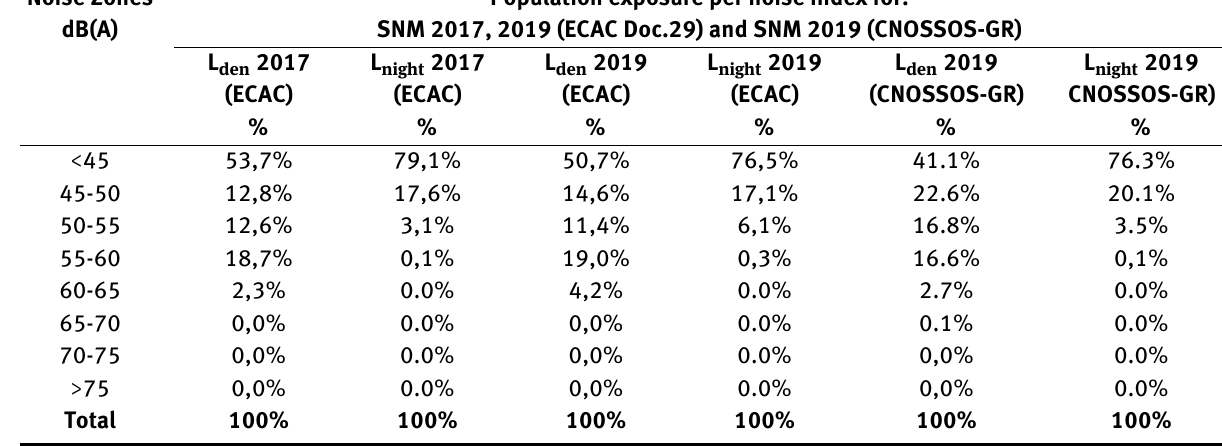
Table 4: Population exposure at all 5 dB(A) buffer zones of L den & L night environmental noise indicators Noise